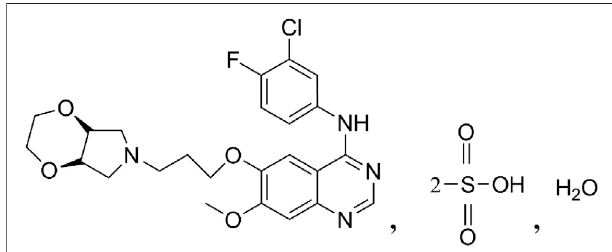
FIGURE 1 | Structure of larotinib